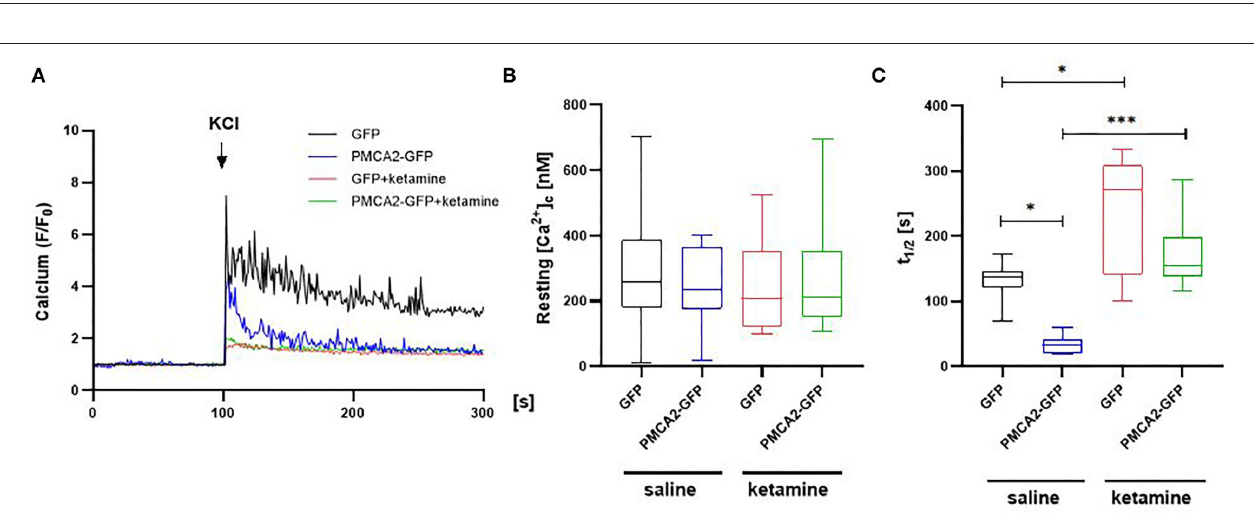
FIGURE 1 | differentiation markers, NF68 and GAP43, determined using the Western blot. For (A–D) , the representative images are presented. (E) Quantification of NF68 and (F) GAP43 band intensity following normalization to endogenous Gapdh level, n = 4. AU, arbitrary units. (G) Flow cytometry analysis of differentiated cell viability in the presence or absence of ketamine. (H) Quantification of Bad phosphorylation at Ser-136. Total Bad and p-Bad Ser-136 protein level determined by the Western blot in the presence of ketamine was normalized to Gapdh, and the results are presented as phosphorylation index (pBad/Bad), n = 3. Representative blots